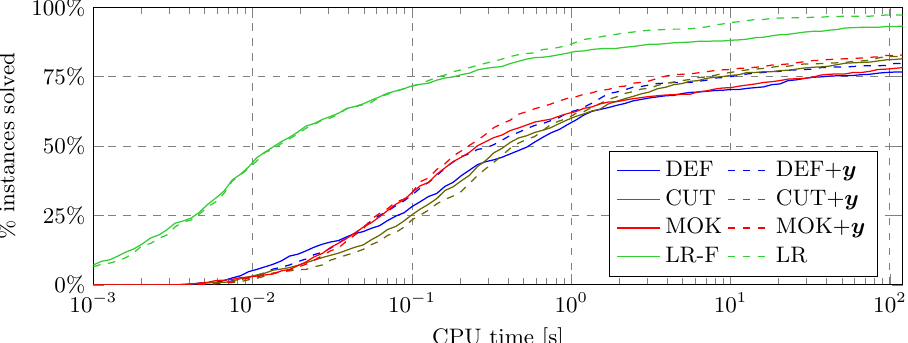
Figure 3 The seven algorithms applied to all the instances, uncorrelated , correlated jobs , and correlated machines